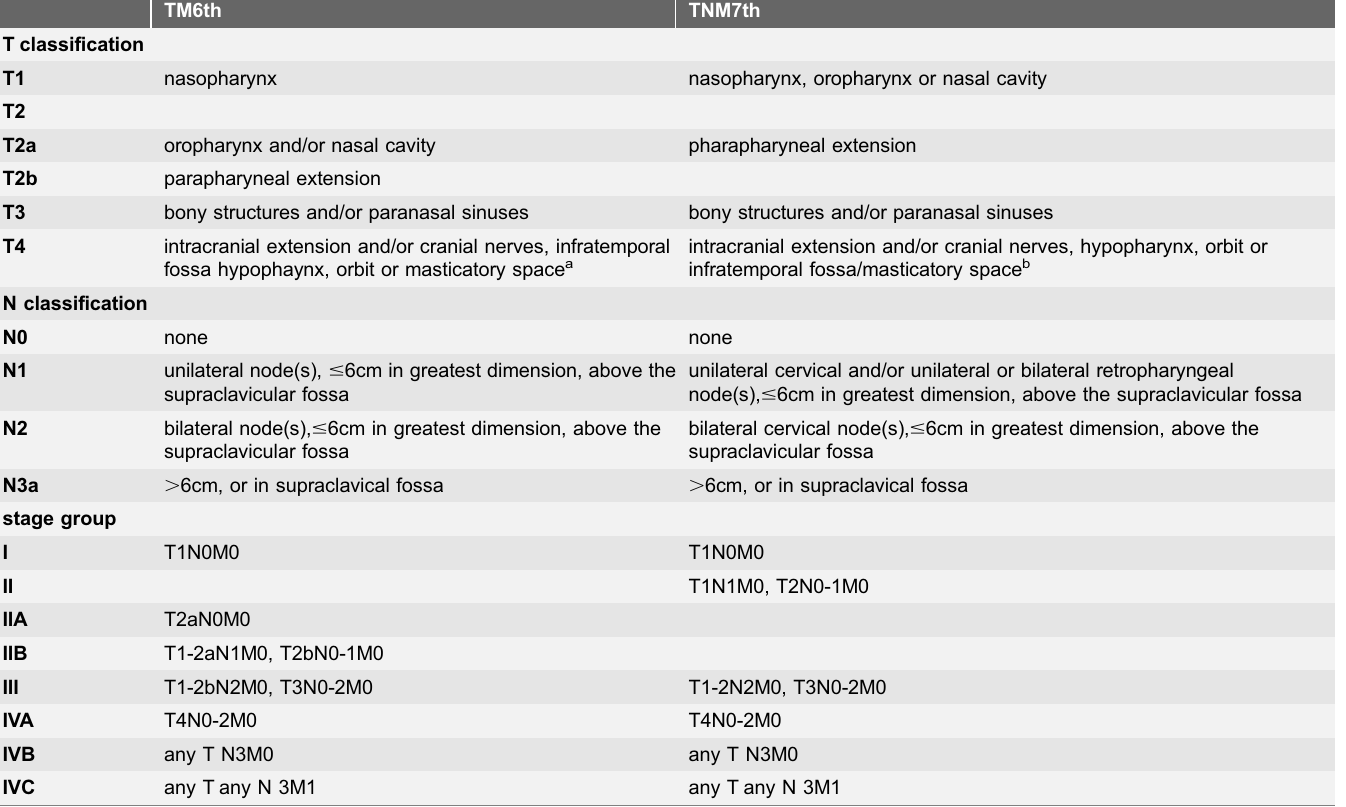
Table 2. Classification criteria of TNM 6th and TNM 7th staging system for nasopharyngeal carcinoma.